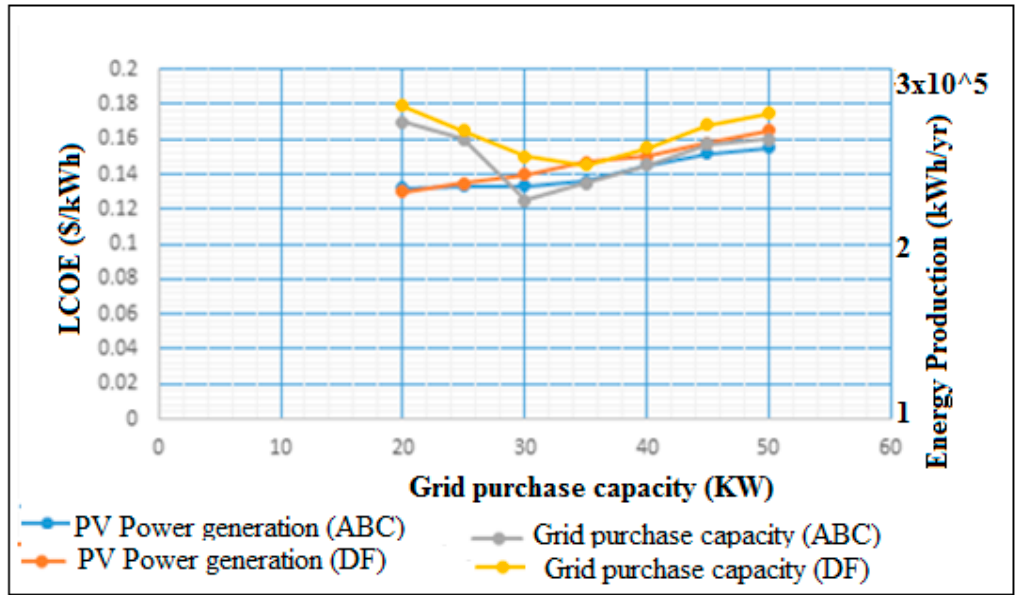
Figure 8. Comparison of PV power generation and grid sale capacity with ABC.